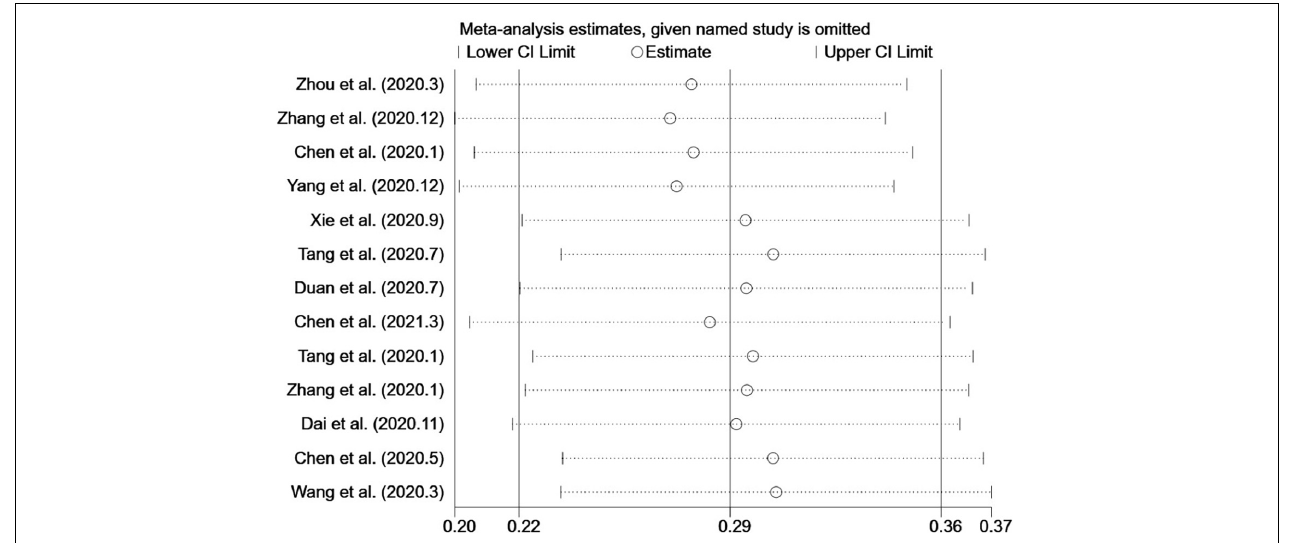
FIGURE 4 | Sensitivity analysis